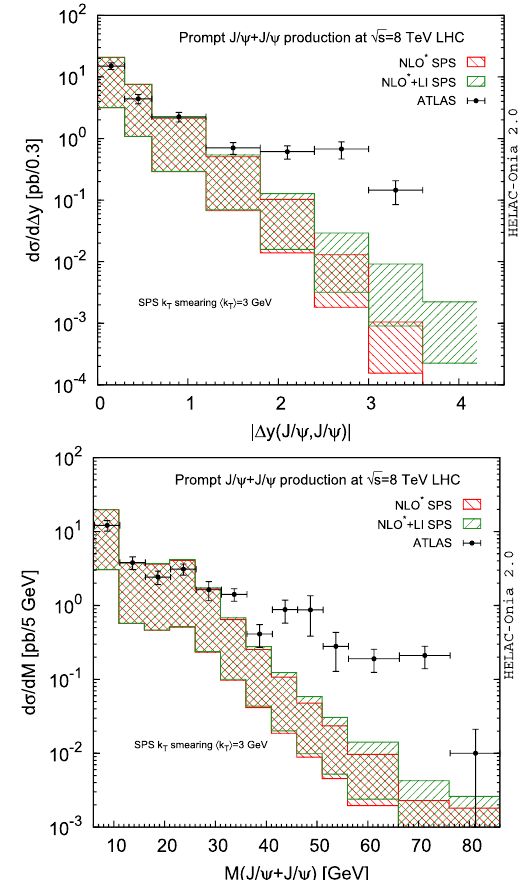
Fig. 2 Rapidity gap | Δ y ( J /ψ, J /ψ) | (left) and invariant mass M ( J /ψ + J /ψ) (right) distributions for di- J /ψ production in CSM √ s = 8 TeV acceptance [22] via SPS within ATLAS